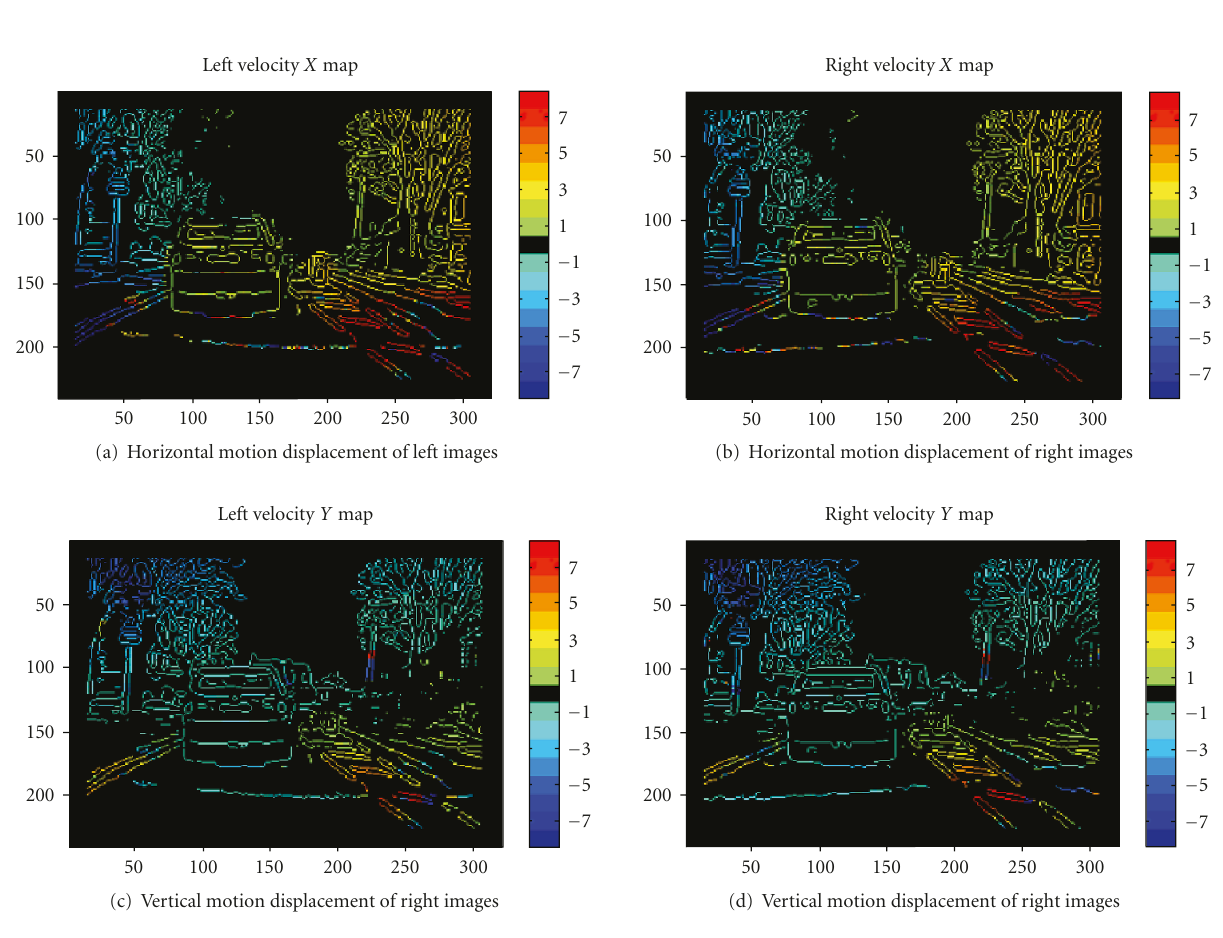
displacements of the left and right image sequences have occurred, which implies that the optic flows can be used as extra constraints for stereo